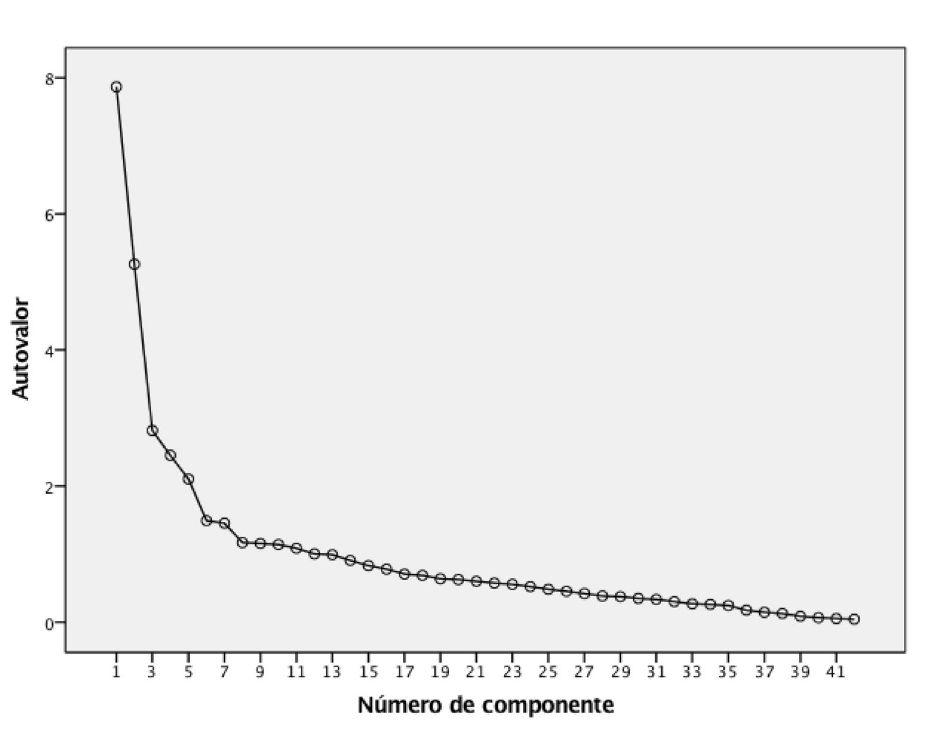
Figure 2. Sedimentation